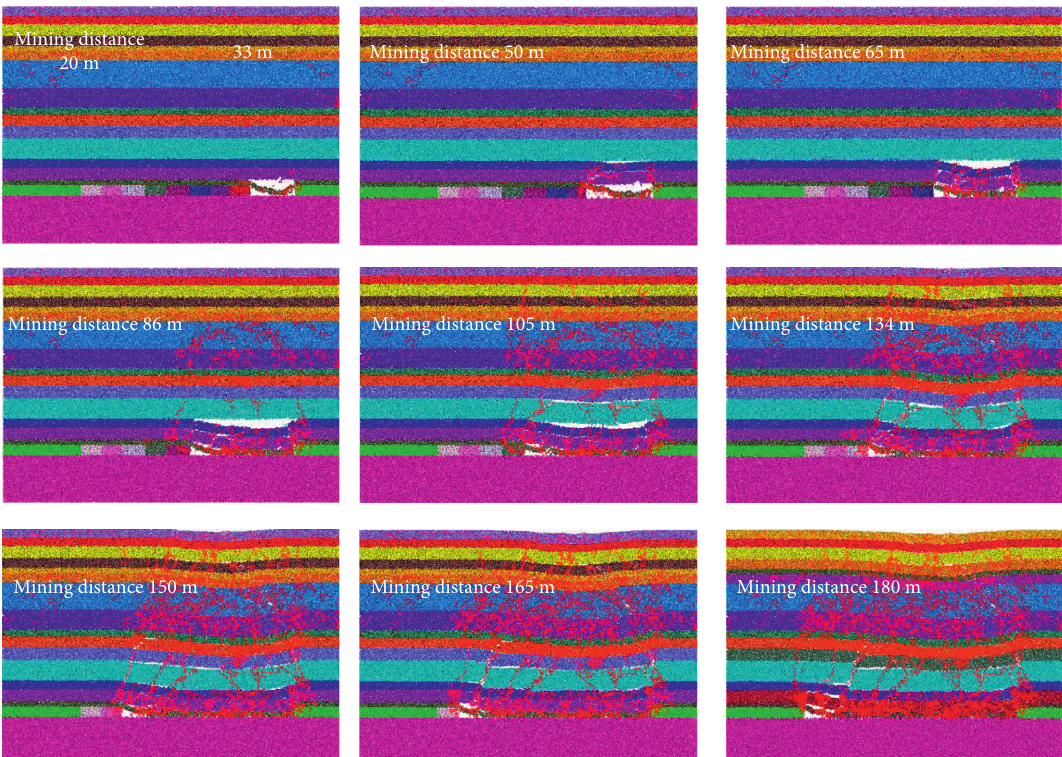
Figure 16: Caving characteristics of mining overlying rock of scheme 3.